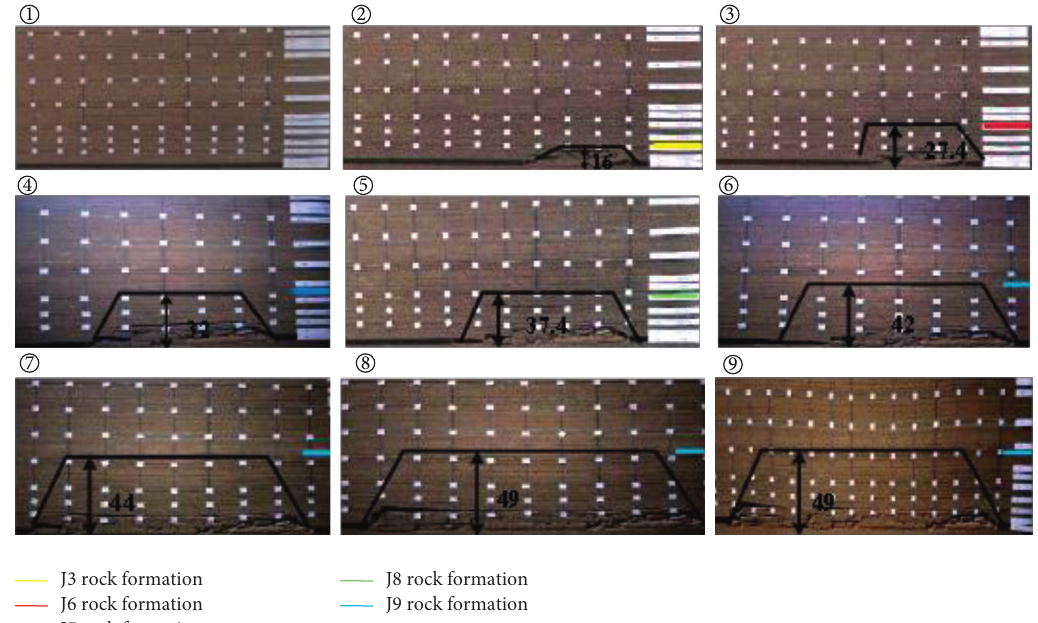
Figure 12: Development height of water-conducting fracture zone of scheme